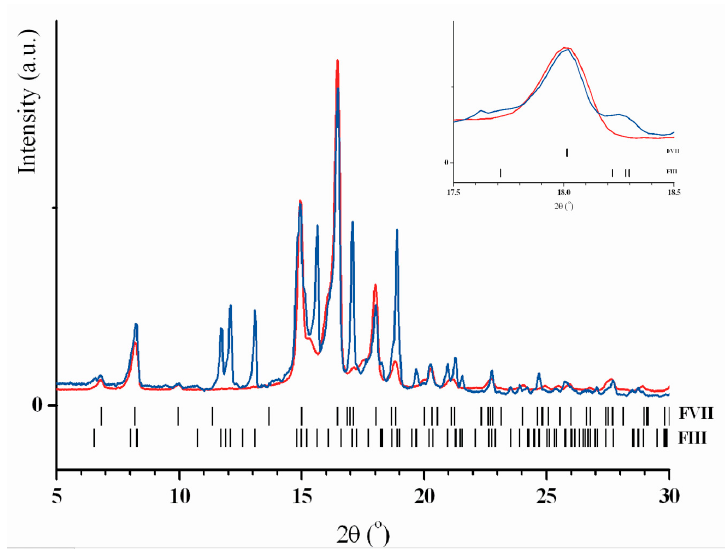
Figure 1. X-ray powder patterns of the cryomodified DHEA.